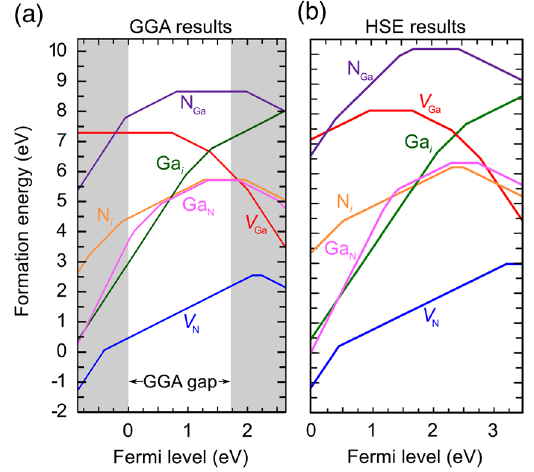
Fig. 3 Formation energies vs. Fermi level for interstitial, vacancy, and antisite defects in GaN, calculated with a GGA and b HSE hybrid functionals. Both sets of formation energies include fi nite-size corrections as described in the text. In a , the white region indicates the GGA-calculated band gap; the Fermi-level range is extended beyond the band maxima ( grey regions) so that the edges of the plot correspond to the HSE range shown in b . In both cases, Ga-rich conditions are